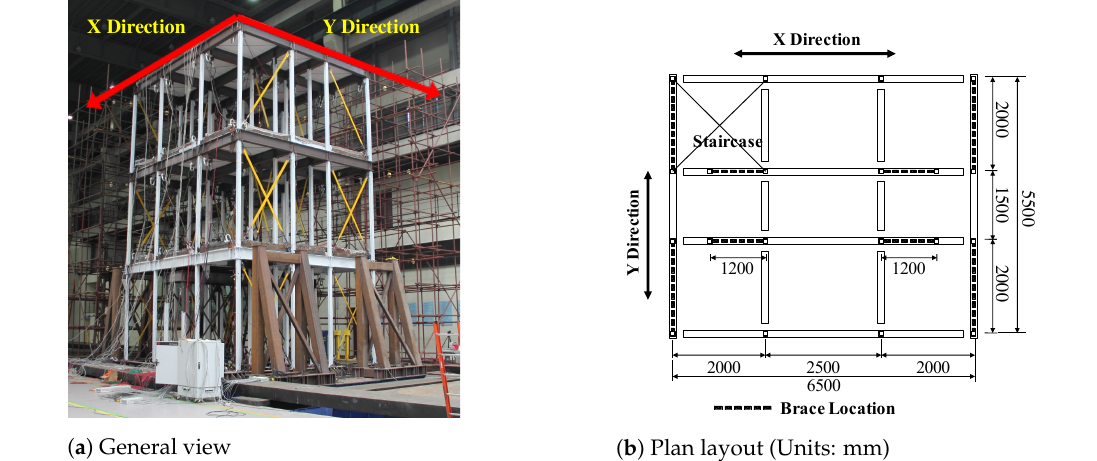
Figure 4. Three-story tension-only concentrically braced beam-through frame (TCBBF).